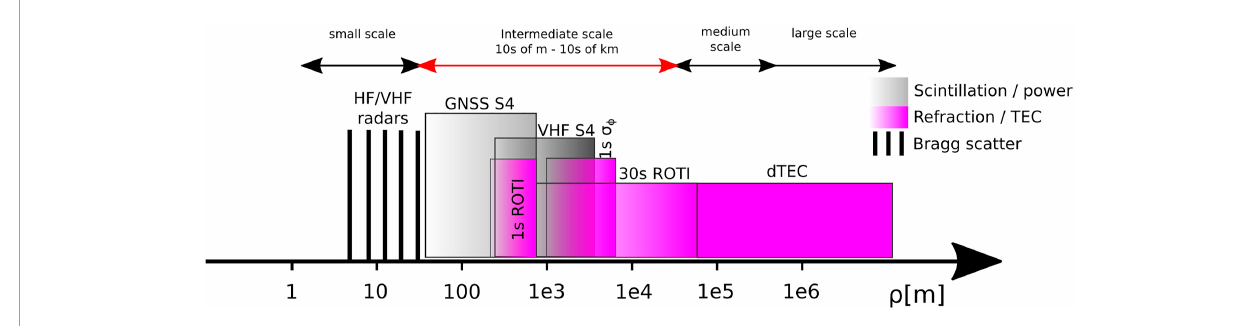
FIGURE 2 A schematic illustration of different radio remote sensing techniques measuring different bands spectra of ionospheric irregularities on the x-axis. The top line denotes ranges of scales, highlighting the intermediate scales. Gray colors indicate observables caused only by ionospheric diffraction. Magenta bands denote predominantly refractive changes in the signal phase and consequently in the TEC. The color intensity is illustrating the level of contribution to this parameter (not to